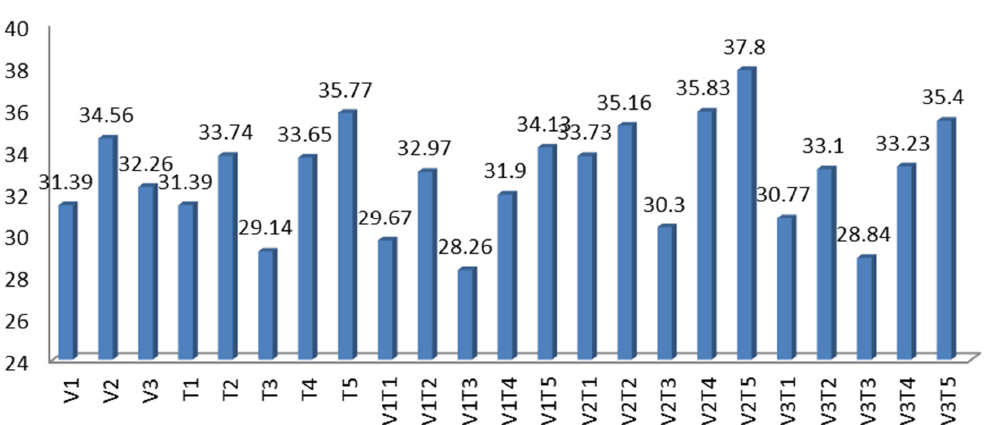
Figure 5. Response of different sweet orange cultivars, time of T-budding and interactions on time for healing of bud union Plant height